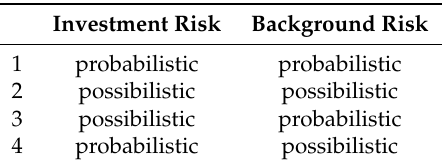
Table 1. Models with background